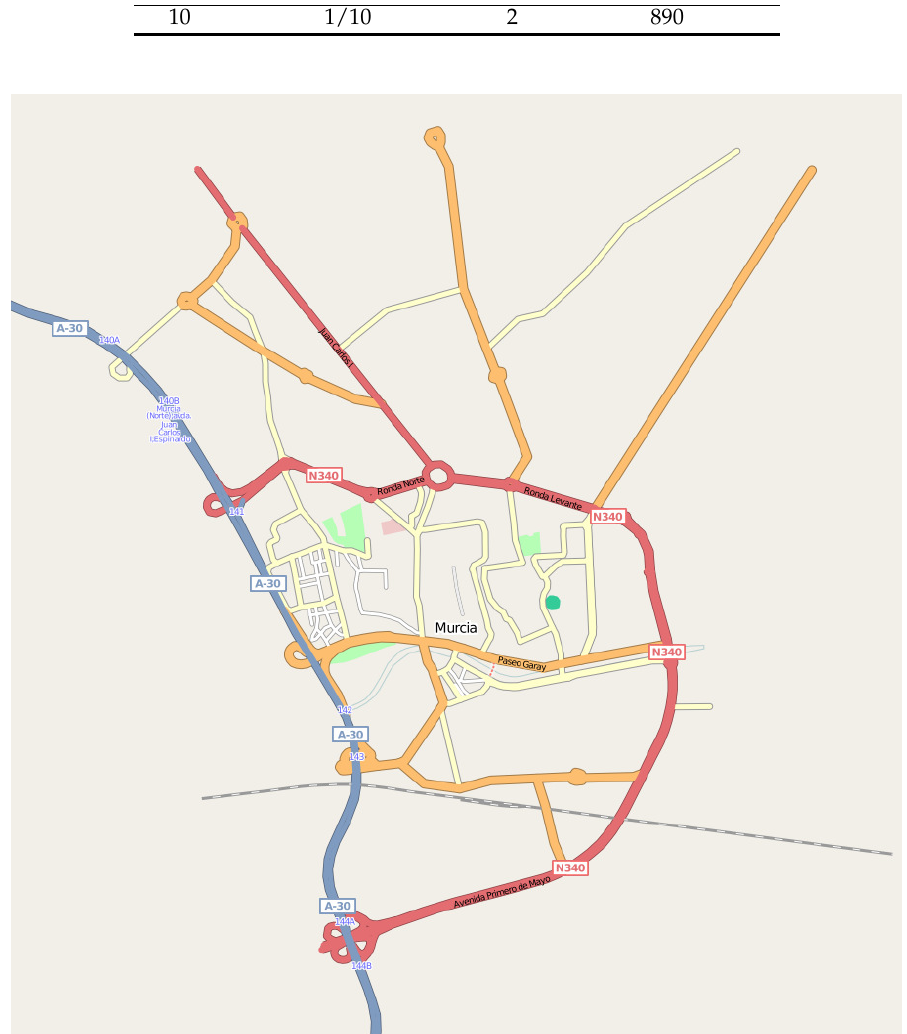
Figure 11. Urban scenario of the city of Murcia used in our